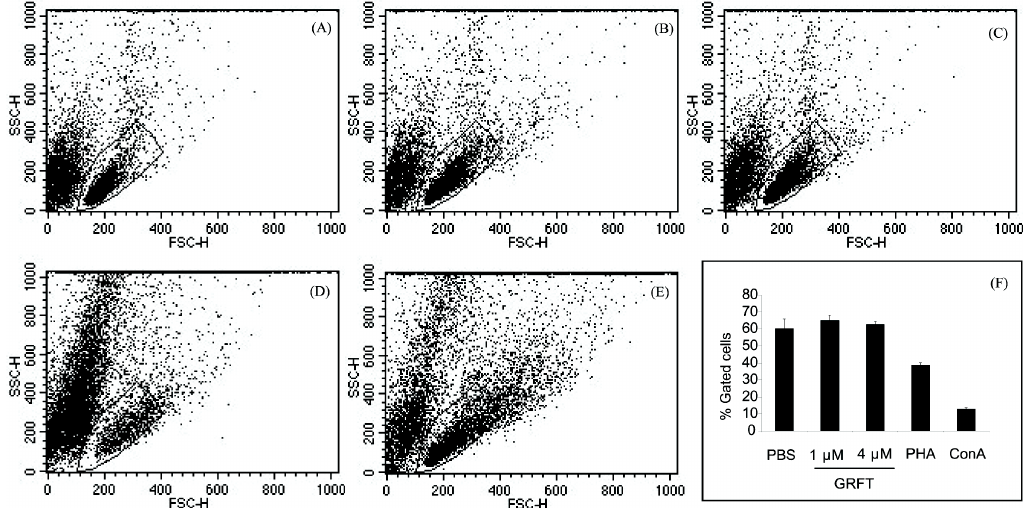
Figure 2. Mitogenic properties of GRFT on mPBMCs. Cells were cultured for three days in the presence of PBS ( A ); 1 and 4 µ M GRFT (( B , C ), respectively); 0.37 µ M ConA ( D ) and 10 µ g/mL phytohemagglutinin (PHA) A ( E ). Dot plots reveal forward scatter (FSC) and side scatter (SSC) of cells after treatment. Typical inactivated mPBMC subpopulations were gated and quantitated ( F